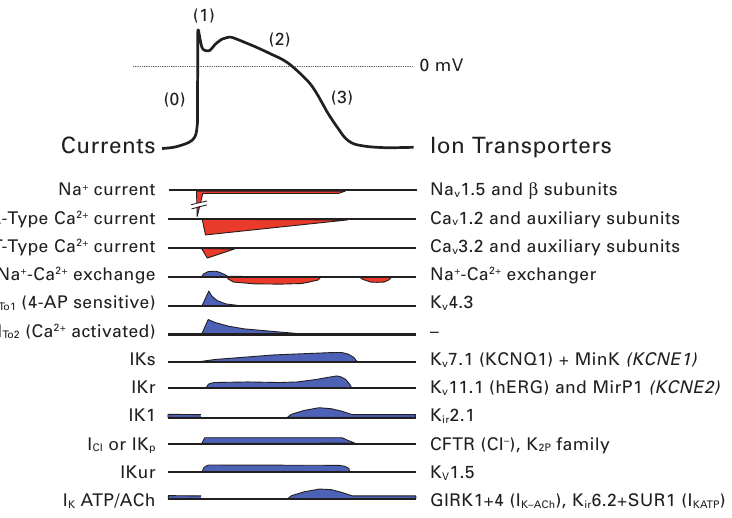
ancillary beta-subunits that are not directly involved in the gating machinery of the channels. The currents generated by all other electrogenic transporters (ATPases, exchangers and ion channels) also contribute to shape the AP.